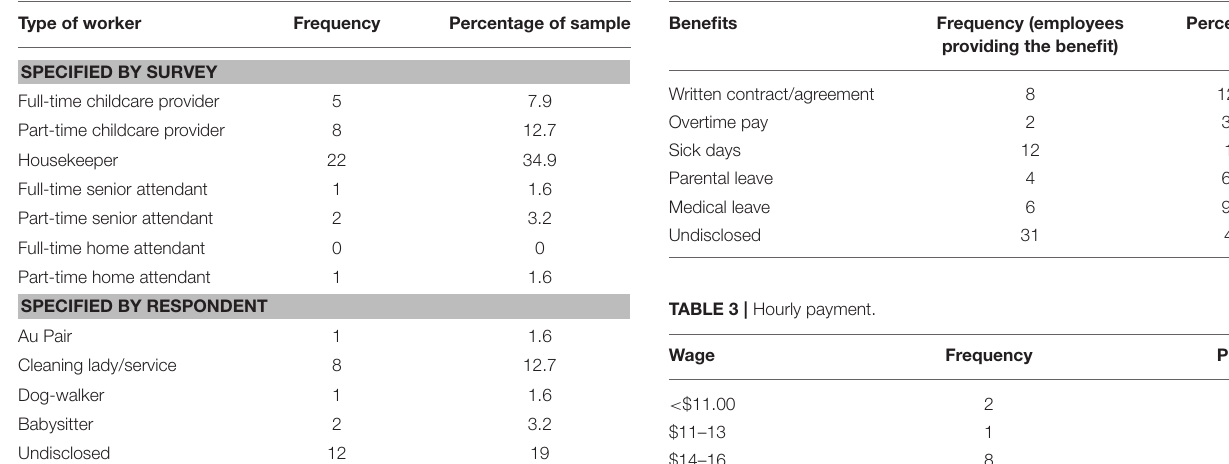
TABLE 1 | Types of workers specified by survey and by respondent. TABLE 2 | Written contracts and benefits received by employees.